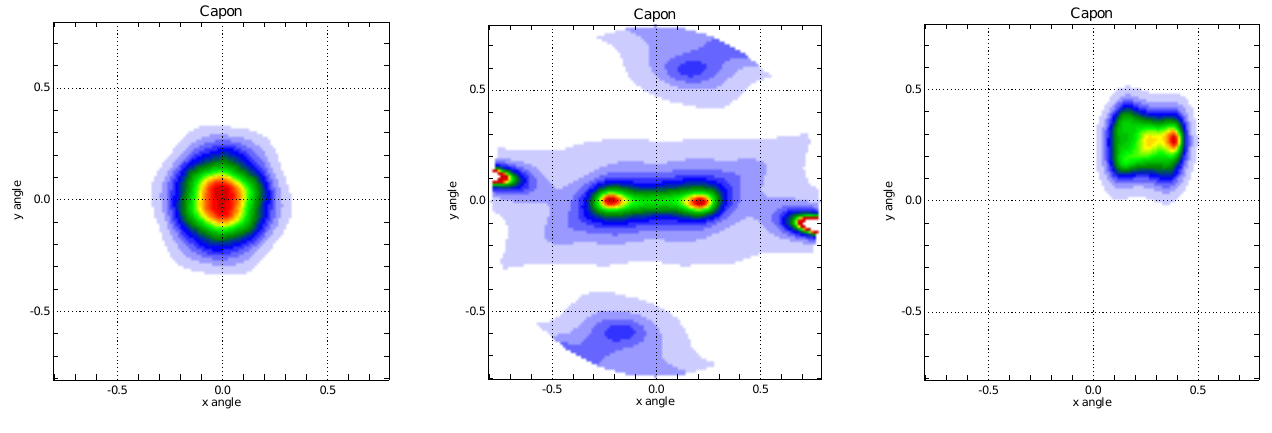
Fig. 8. Images of the model brightnesses of Fig. 1 obtained using the antenna configuration of Fig. 6 and the Capon method.